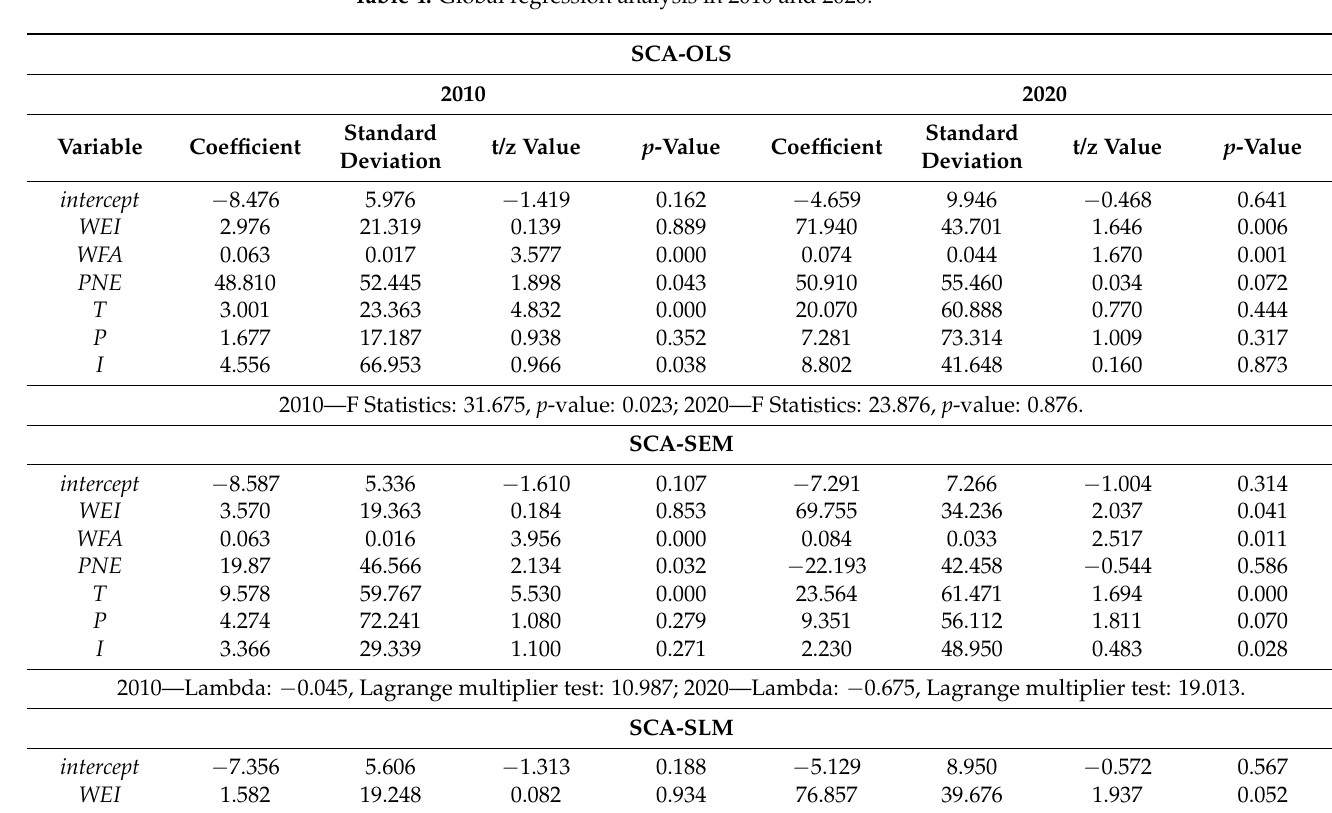
Table 4. Global regression analysis in 2010 and